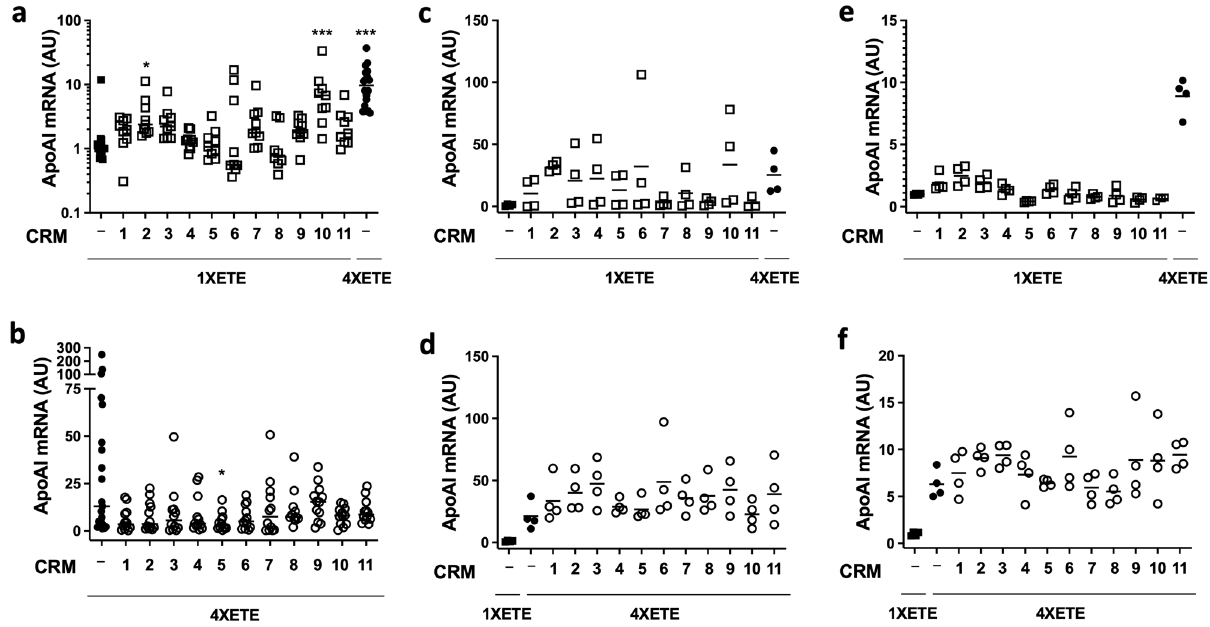
Figure 4. Testing of APOAI expression cassettes containing cis-regulatory modules (CRM) in endothelial cells. ( a ) Bovine aortic endothelial cells (BAEC) were transfected with pBshuttle-1XETE-gApoAI-oPRE either without an added CRM (−) or with one of the CRM identified via the process in Fig. 3. BAEC were also transfected with pBshuttle-4XETE-gApoAI-oPRE, without an added CRM. Median APOAI expression for 1XETE-gApoAI-oPRE is assigned a value of 1; all other points are measured relative to this value. ( b ) BAEC were transfected with pBshuttle-4XETE-gApoAI-oPRE without an added CRM (−) or with one of the CRM. ( c ) Human aortic endothelial cells (HAEC) were transfected with pBshuttle-1XETE-gApoAI-oPRE either without an added CRM (−) or with 1 of the CRM. HAEC were also transfected with pBshuttle-4XETE-gApoAI-oPRE, without an added CRM. ( d ) HAEC were transfected with pBshuttle-4XETE-gApoAI-oPRE without an added CRM (−) or with 1 of the CRM. HAEC were also transfected with pBshuttle-1XETE-gApoAI-oPRE, without an added CRM. ( e ) Human umbilical vein endothelial cells (HUVEC) were transfected with pBshuttle-1XETE- gApoAI-oPRE either without an added CRM (−) or with 1 of the CRM. HUVEC were also transfected with pBshuttle-4XETE-gApoAI-oPRE, without an added CRM. ( f ) HUVEC were transfected with pBshuttle-4XETE- gApoAI-oPRE without an added CRM (−) or with 1 of the CRM. HUVEC were also transfected with pBshuttle- 1XETE-gApoAI-oPRE, without an added CRM. ( c – f ) Mean APOAI expression for 1XETE-gApoAI-oPRE is assigned a value of 1; all other points are measured relative to this value. ( a – f ) APOAI mRNA was measured by RT-qPCR, 24 h after transfection. Data are from three ( a ); four ( b ); or two ( c – f ) independent experiments; bars are group medians ( a , b ) or group means ( c – f ). ( a ) * P < 0.05; *** P < 0.001 vs. 1XETE-gApoAI-oPRE. ( b ) * P < 0.05 vs.